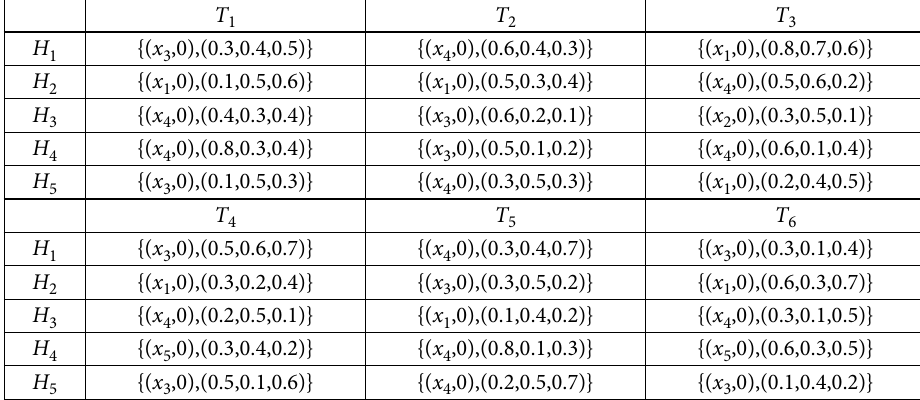
Table 3. Evaluation matri x by W